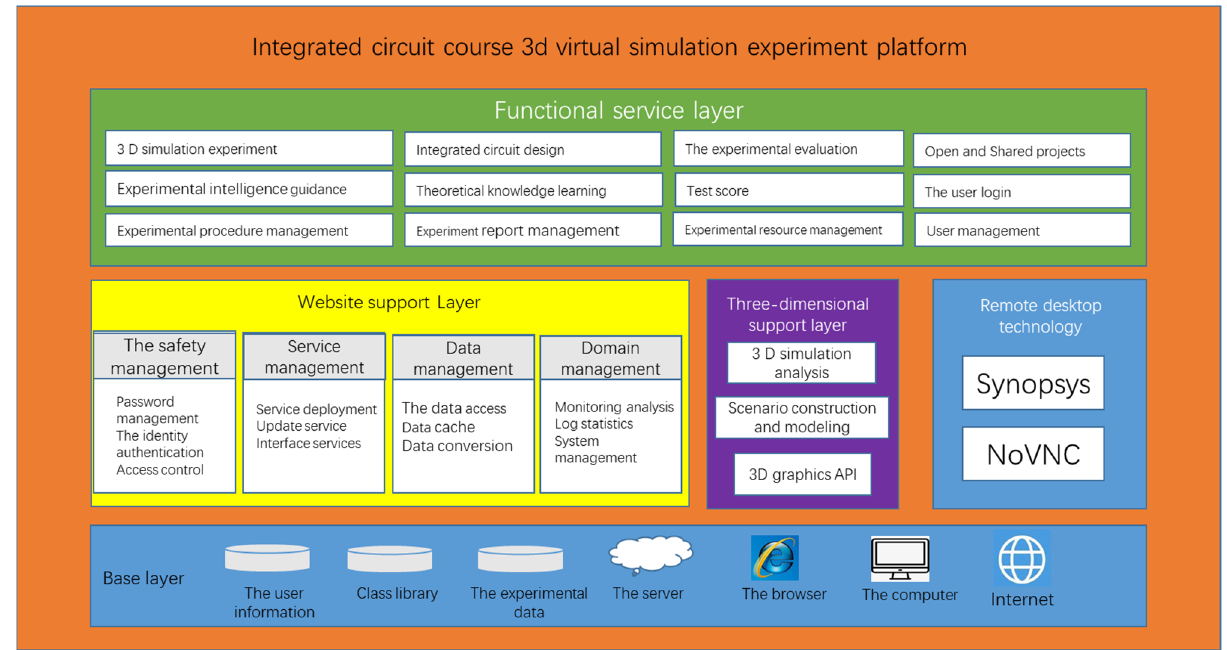
Figure 2. Overall design process scheme of virtual simulation platform.